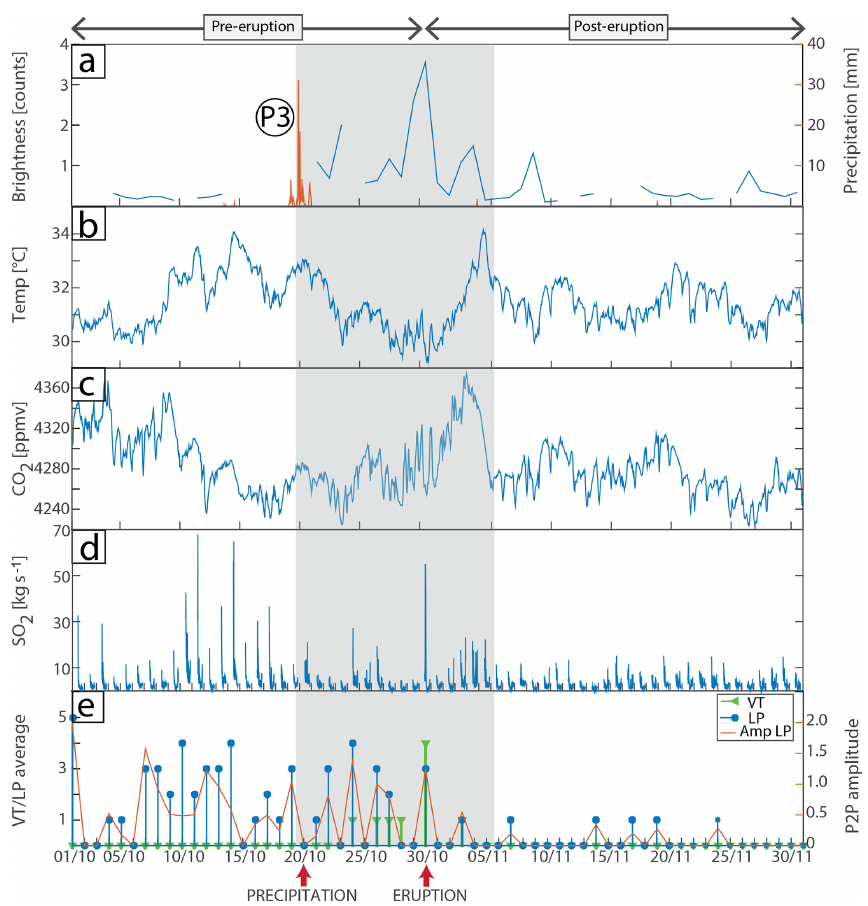
Figure 4. Two months of daily variations shown in multiparametric plots of data. (a) Brightness (blue curve) of the fumarole computed at noon and precipitation event P3 (orange curve for P3; see Fig. 2), (b) fumarole (blue) temperature, (c) CO 2 mixing ratio, (d) SO 2 emission rate (note that the data show a peak during the eruption), and (e) VT and LP seismic-event average and LP peak-to-peak amplitude (orange curve). Precipitation event P3 and day of eruption are indicated with arrows at the bottom. The shaded box indicates the period covered from the onset of precipitation event P3 to a few days after the eruption, during which high variability was observed in the gas plume and